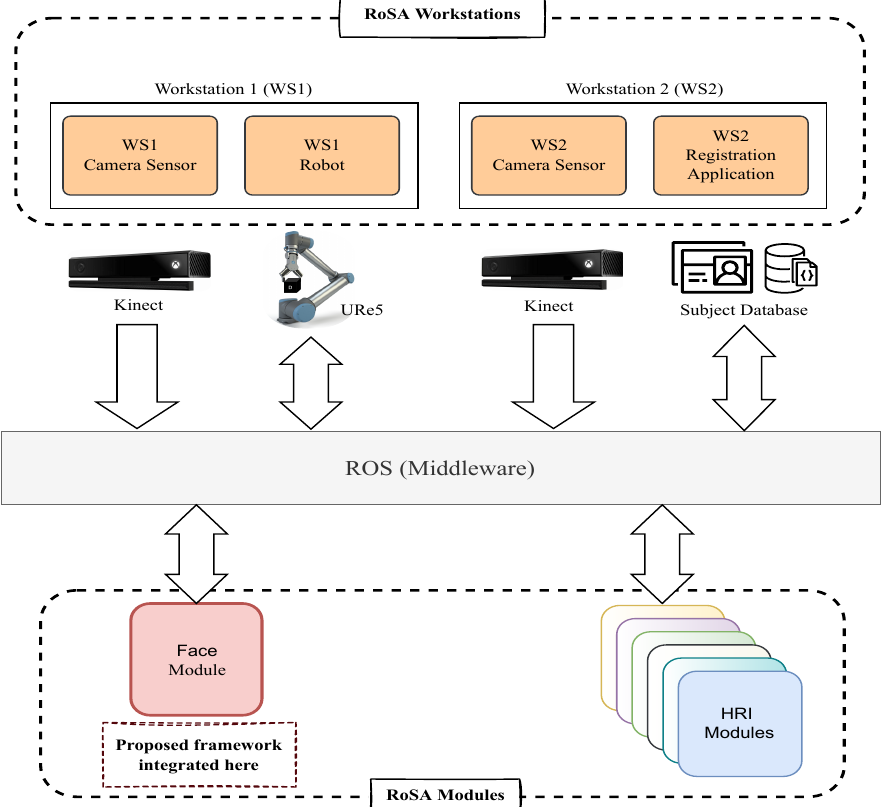
Figure 3. The system setup of the Robot System Assistant (RoSA) framework, showing the communi- cation between the RoSA modules and workstations, is performed via the ROS, and the proposed framework is integrated as the face